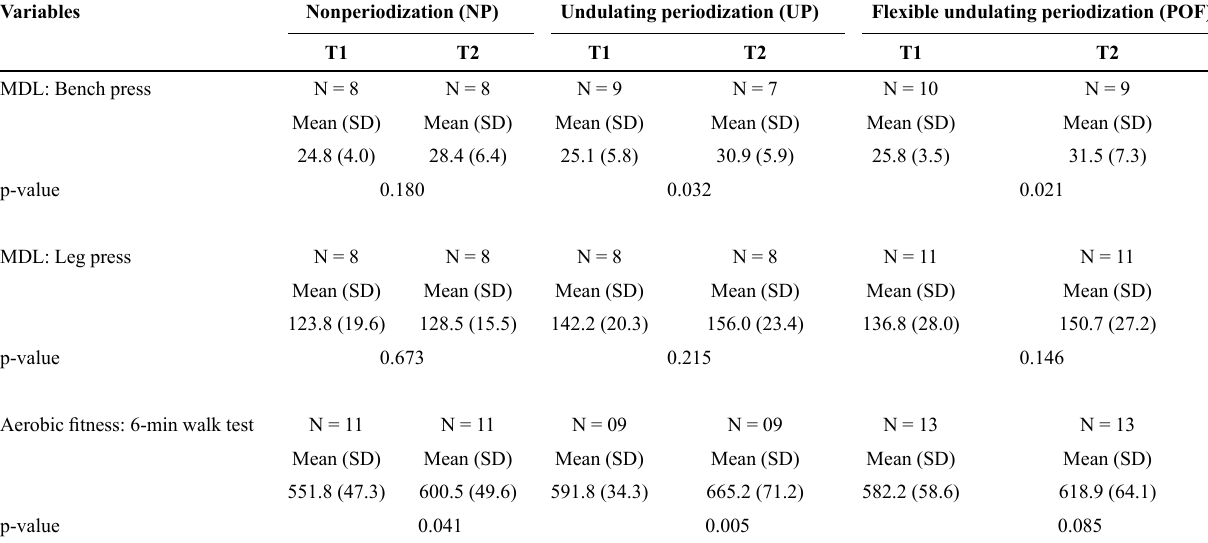
Table 4 - Evaluation of the participants’ strength as measured by the maximum dynamic load with the inclined bench press and leg press and assessment of aerobic fitness as measured in the 6-min walk test, by physical training group and evaluation time.